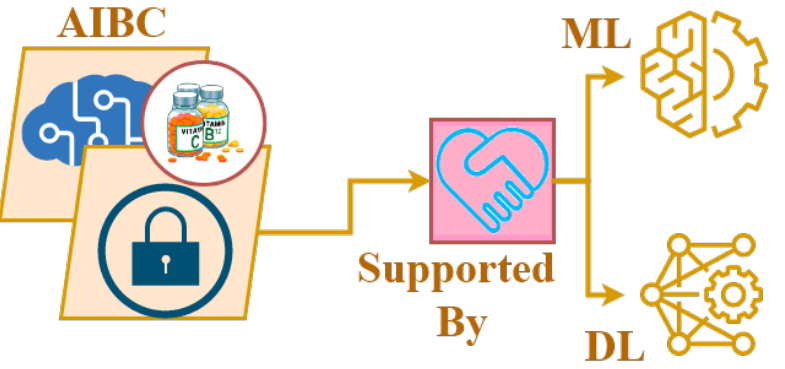
Figure 5. AIBC: Supported by ML and